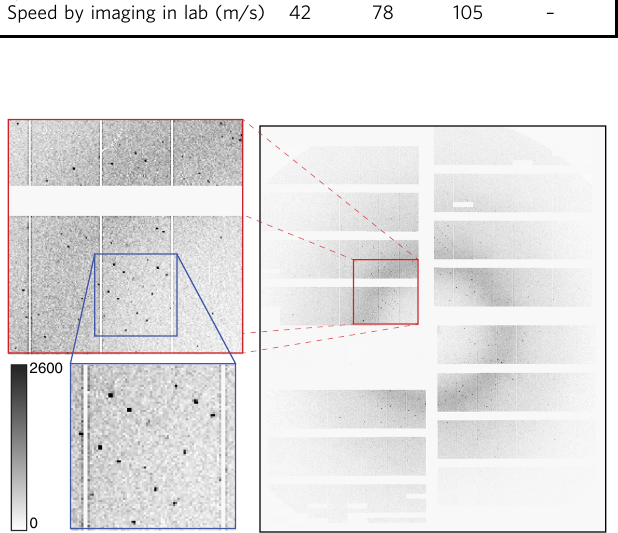
Fig. 2 Diffraction pattern from HEWL. Diffraction pattern from a single HEWL microcrystal measured using MHz pulses of 50 fs duration X-rays at 9.3 keV using the AGIPD 1M detector in the SPB/SFX instrument. Dynamic gain switching of the AGIPD detector enables simultaneous low noise and high dynamic range: each pixel has three gain settings which are automatically selected depending on the per-pixel cumulative intensity to simultaneously maximize sensitivity and dynamic range. Image clipped at 2600 counts to show content, full dynamic range of brightest spots extends to 109,000